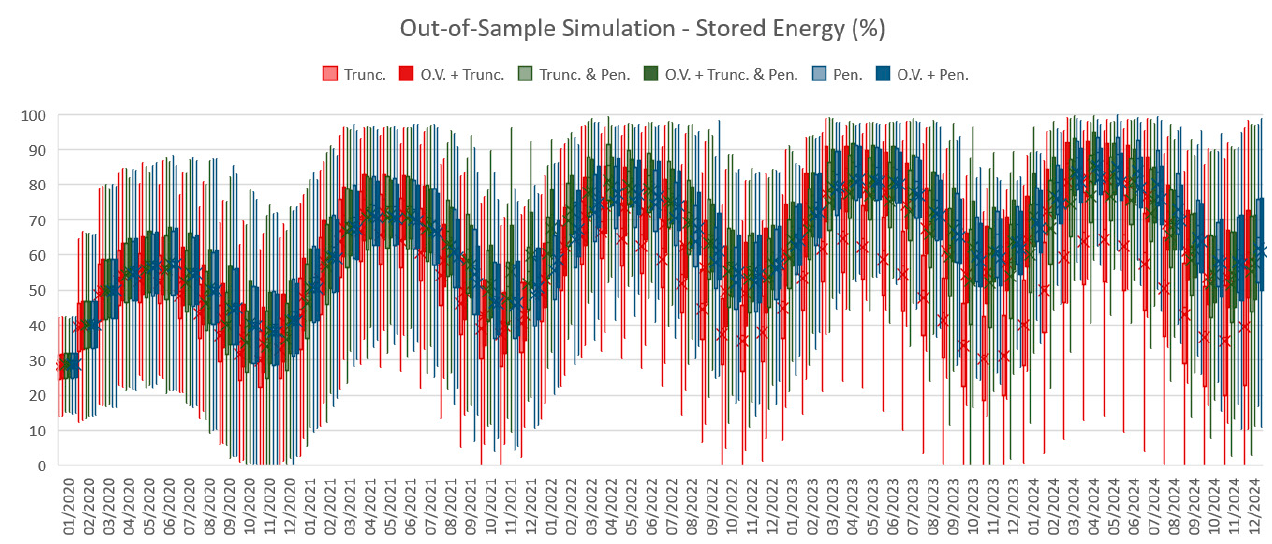
Figure 15. Stored energy obtained by out-of-sample simulation in the percentage of the maximum stored energy of the system.